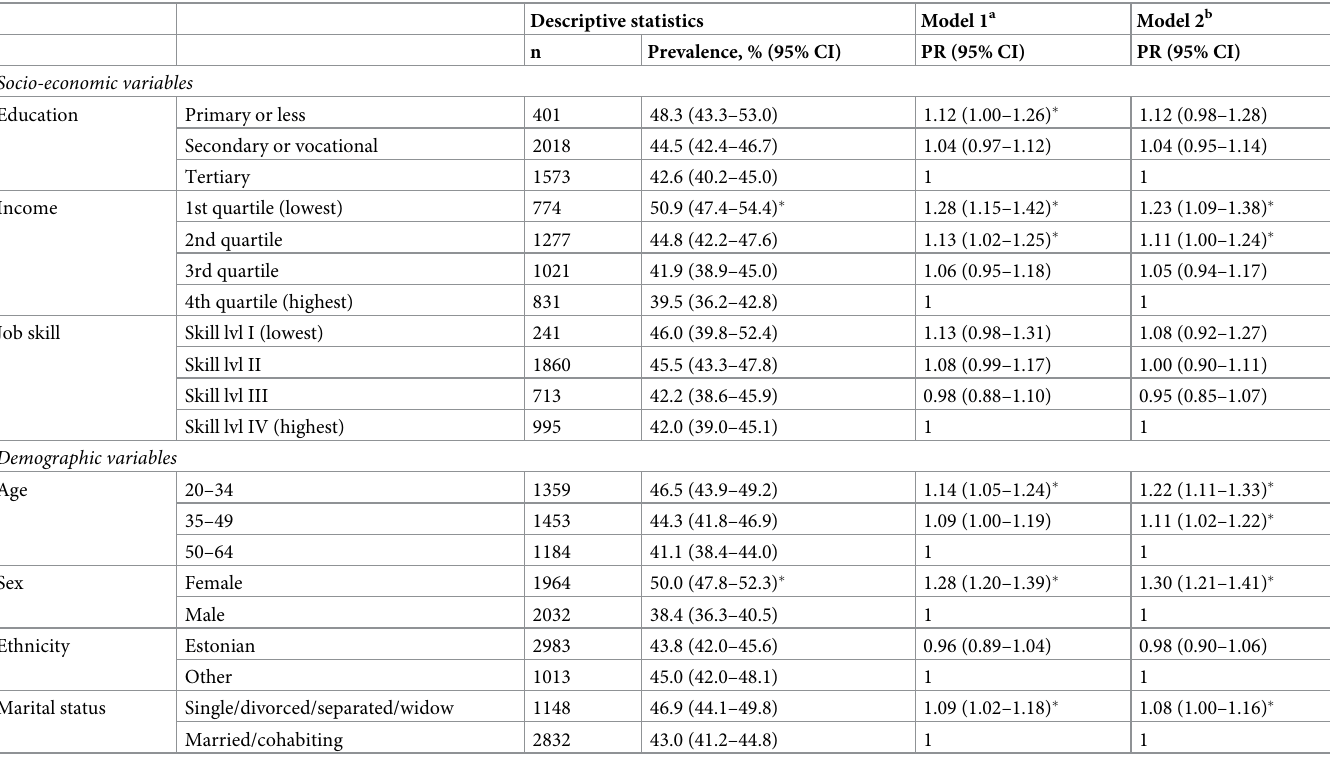
Table 3. Overtiredness and association with socio-economic and demographic variables, descriptive statistics and prevalence ratios with 95%